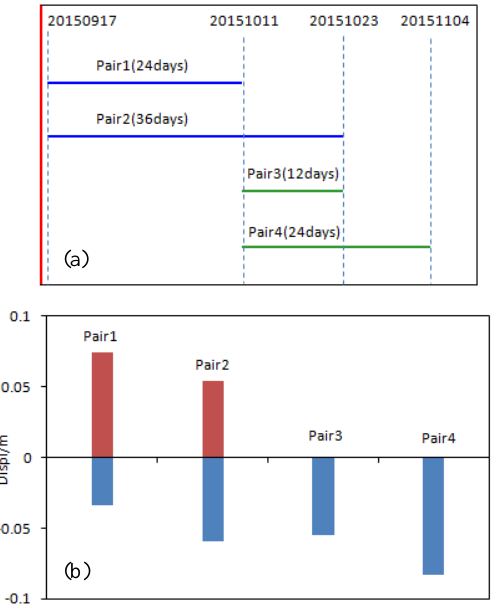
Figure 3. (a) Schematic showing the time spans of the four post- seismic SAR image pairs. Dotted vertical lines are SAR image acquisition dates. Red vertical line shows the date of the